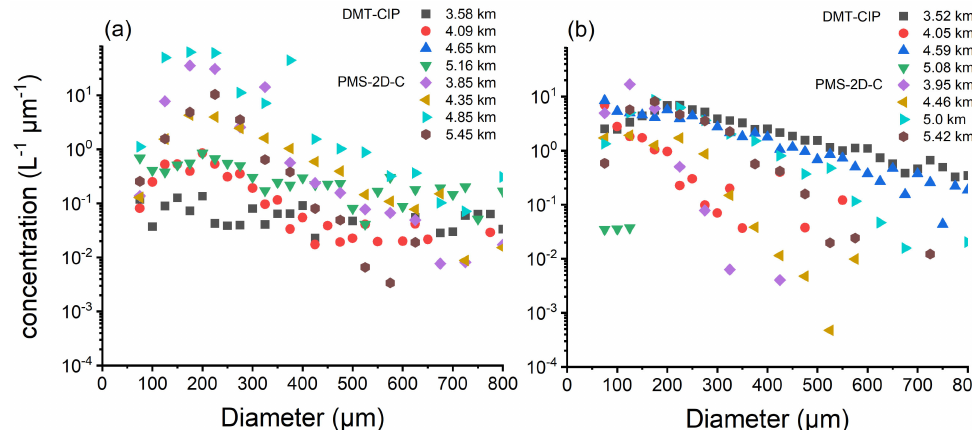
Figure 6. PSD (75–800 µ m) detected by FF: ( a ) PMS-2D-C (3.85, 4.35, 4.85, 5.45 km), DMT-CIP (3.58, 4.09, 4.65, 5.16 km), SF: ( b ) PMS-2D-C (3.95, 4.46, 5.0, 5.42 km), DMT-CIP (3.52, 4.05, 4.59, 5.08